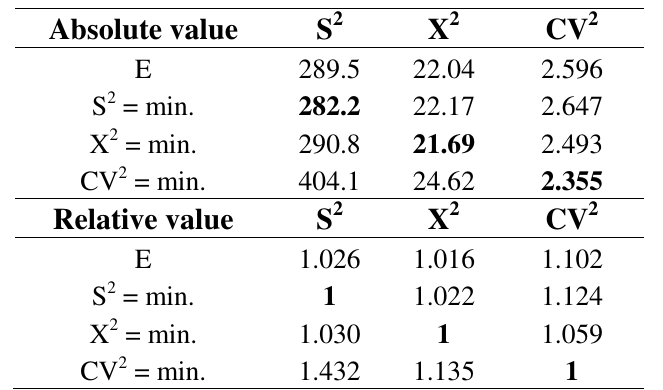
Table 8. Transformation of the residuals presented in Table 7 in relation to their minimum values.